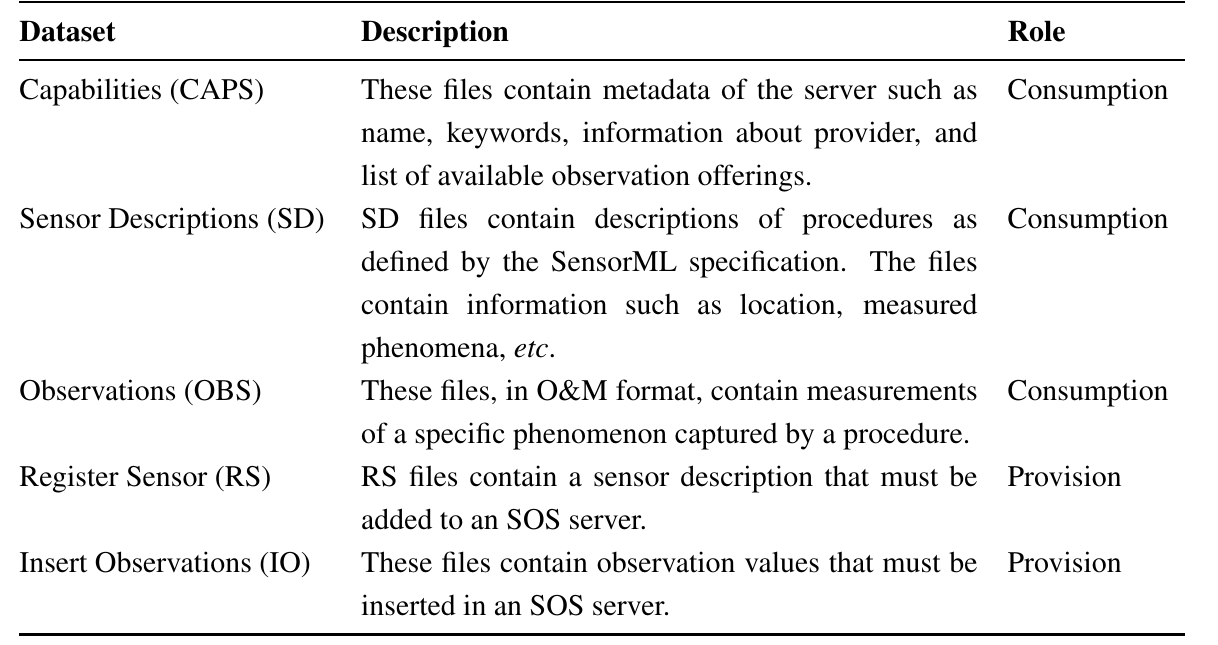
Table 1. Description of selected